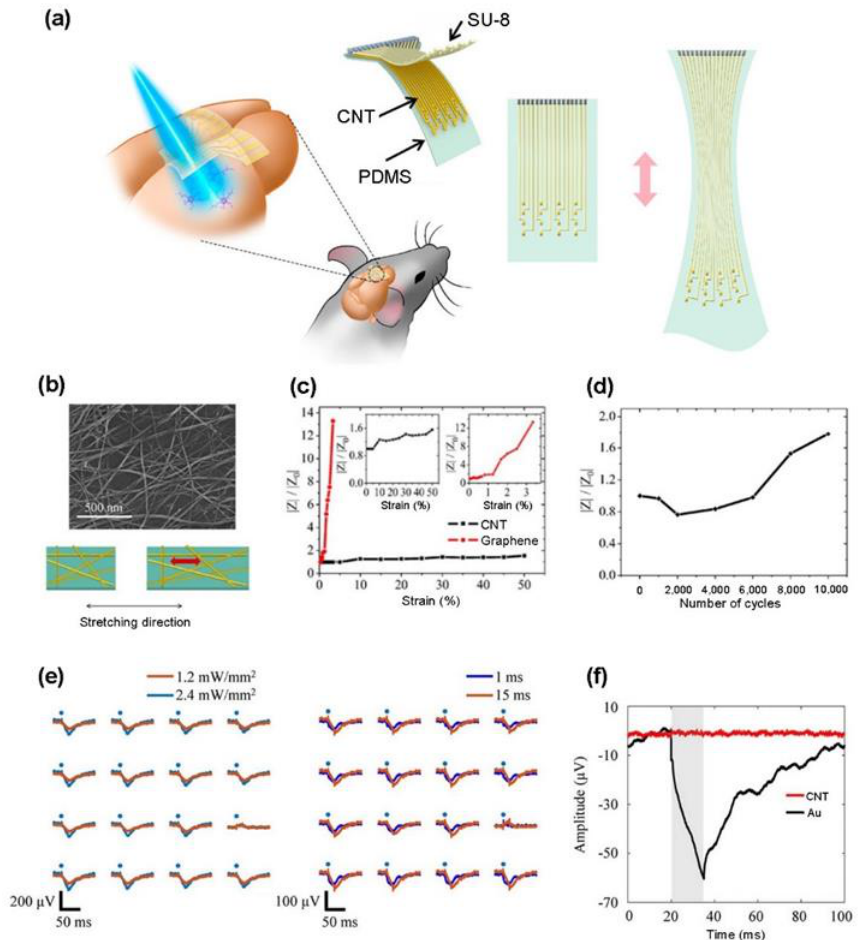
Figure 2. CNT-based transparent electrode arrays for simultaneous electrical recording and optical stimulation: ( a ) schematic illustrations of the stretchable transparent CNT electrode array and its application for optogenetics; ( b ) an SEM image of the CNT network thin film (top) and a schematic illustration of the CNT network thin film under stretching (bottom); ( c ) the strain-dependent impedance change at 1 kHz of the CNT and graphene electrodes under the applied tensile strain; ( d ) impedance change at 1 kHz of a CNT electrode during 10,000 stretching cycles with 20% strain; ( e ) the mapping of evoked potentials after optical stimulations under different stimulus intensity (left) and duration (right). Blue dots indicate the stimulus time points; and ( f ) the light-induced artifacts in CNT and Au electrodes under a photostimulus (2.4 mW/mm 2 , 15 ms). The gray box indicates the duration of stimulation pulses. Reproduced with permission from Zhang et al. [110], copyright 2018, American Chemical Society.